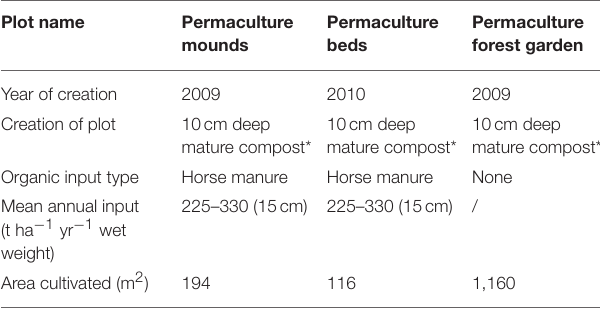
TABLE 2 | Characteristics of cultivation of the permaculture